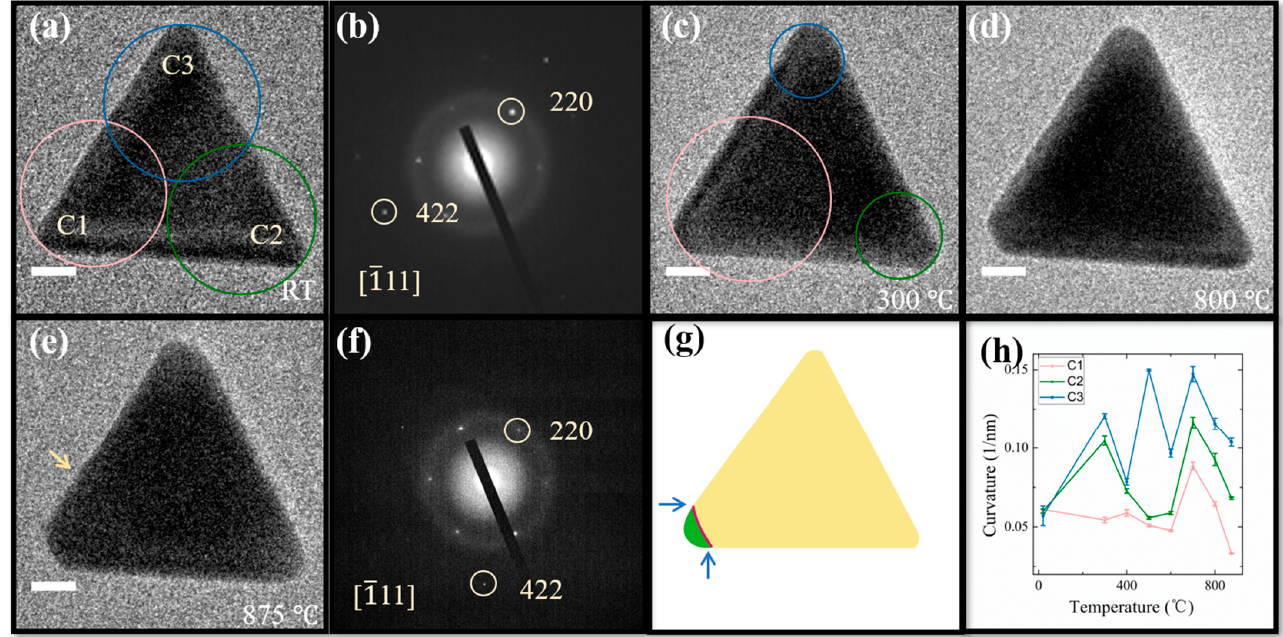
Figure 1. Thermal stability investigation of Au nanoprism. ( a , c – e ) Bright-field TEM images of a Au nanoprism recorded at room temperature (RT), 300, 800 and 875 °C, respectively. ( b , f ) Electron diffraction patterns acquired at the temperatures corresponding to ( a , e ), respectively. Crystallographic analyses based on these diffraction patterns manifest that the nanoprism is surrounded by {442} facets. The arrow in ( e ) indicates a slight edge deformation appearing when the quasi-melting point is reached. ( g ) A brief diagram illustrating the intersection formed between flat and spherical surfaces. ( h ) The curvature changes measured at the corners C1, C2 and C3 as marked in ( a ) as a function of temperature. The radius of curvature was determined by drawing a circle that closely fits the short-curved edge as indicated at each of the corners in ( a , c ). The error bars are the standard deviations from multiple measurements. Scale bars for ( a , c – e ): 10 nm.